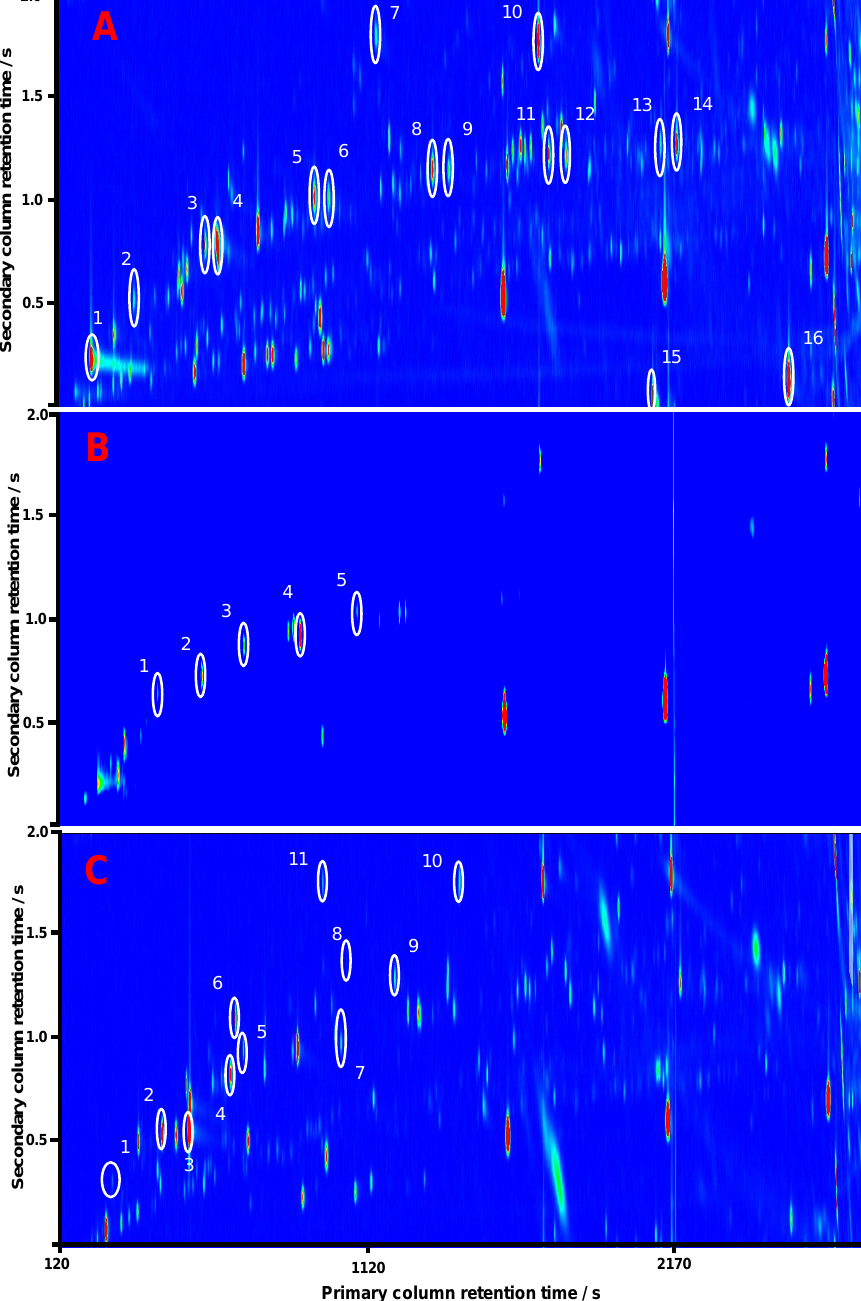
Figure 10. Typical chromatogram from a sample taken during RONOCO (flight B570 canister 34). (A) EIC of m/z 58+95+112+120+128, highlighting the presence of oxygenated species. Labelled peaks are identified as follows: (1) acetone, (2) 2-butanone, (3) 2-pentanone, (4) pentanal, (5) 2-hexanone, (6) hexanal, (7) furfural, (8) 2-heptanone, (9) heptanal, (10) phenol, (11) 2-octanone, (12) octanal, (13) 2-nonanone, (14) nonanal, (15) acetophenone and (16) naphthalene. (B) EIC m/z 46, highlighting the presence of alkyl nitrate species. Labelled peaks are identified as follows: (1) ethyl nitrate, (2) isopropyl nitrate, (3) propyl nitrate, (4) sec -butyl nitrate and (5) butyl nitrate. (C) EIC m/z 63 +83+86+93+112+117+166+170+172+174, highlighting the presence of halocarbon species. Labelled peaks are identified as follows: (1) dichloromethane, (2) chloroform, (3) carbon tetrachloride, (4) 1,2-dichloropropane, (5) bromodichloromethane, (6) dibromomethane, (7) tetrachloroethylene, (8) dibromochloromethane, (9) chlorobenzene, (10) tribromomethane and (11) 2-iodopropane.